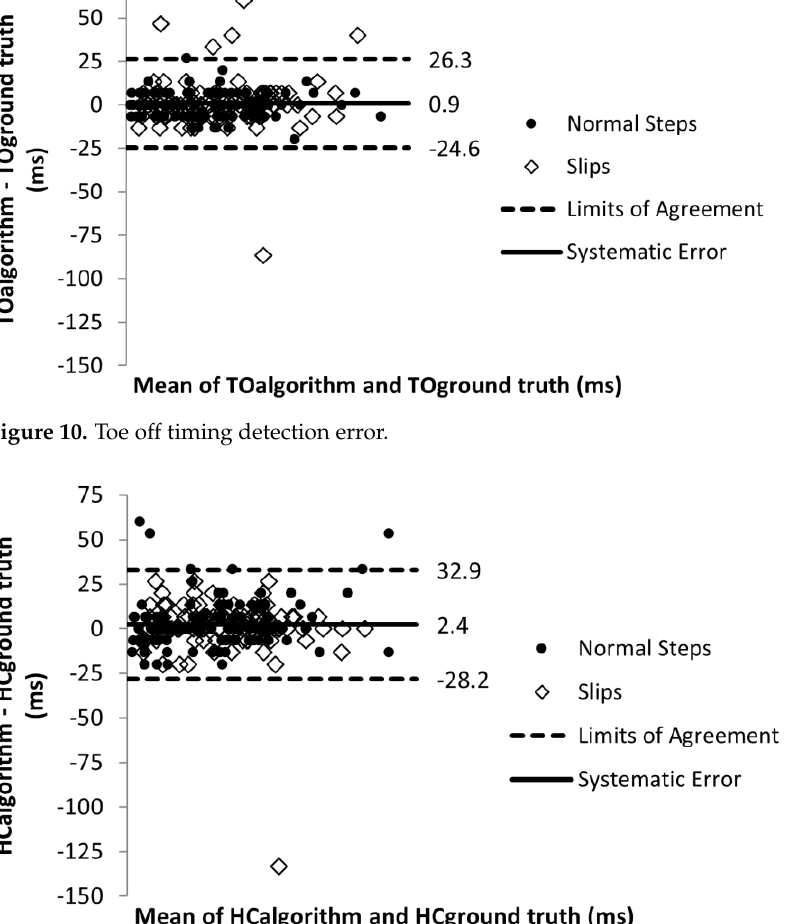
Figure 10. Toe off timing detection error.